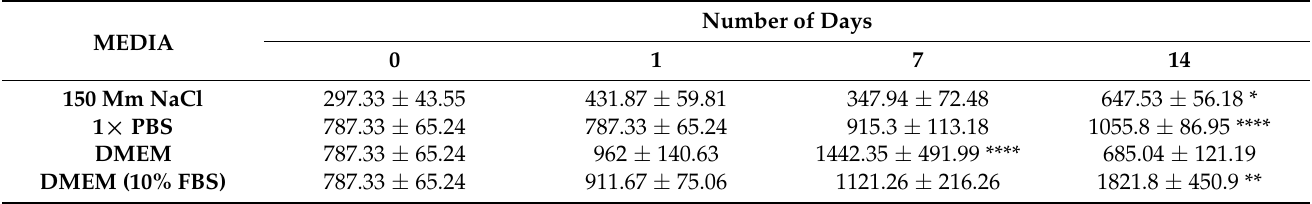
Table 1. Hydrodynamic diameter (nm) of TiO 2 NPs after being exposed to various physiological medias over a 2-weeks period. Table 2. Zeta Potential (mV) of TiO 2 NPs after being exposed to various physiological medias over a 2-weeks